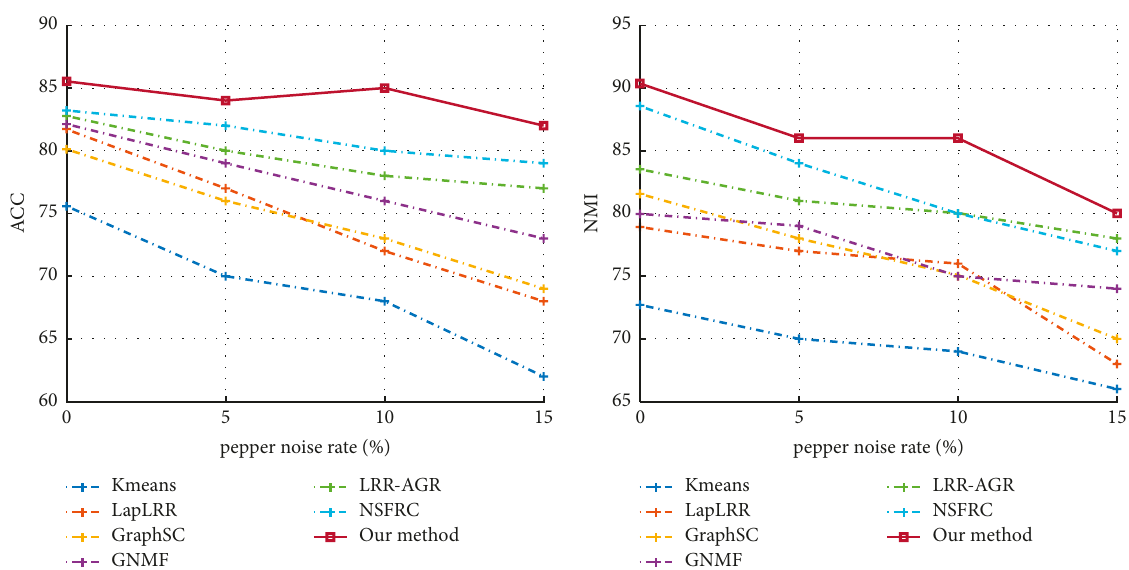
Figure 4: Clustering performances of different algorithm on corrupted UCI